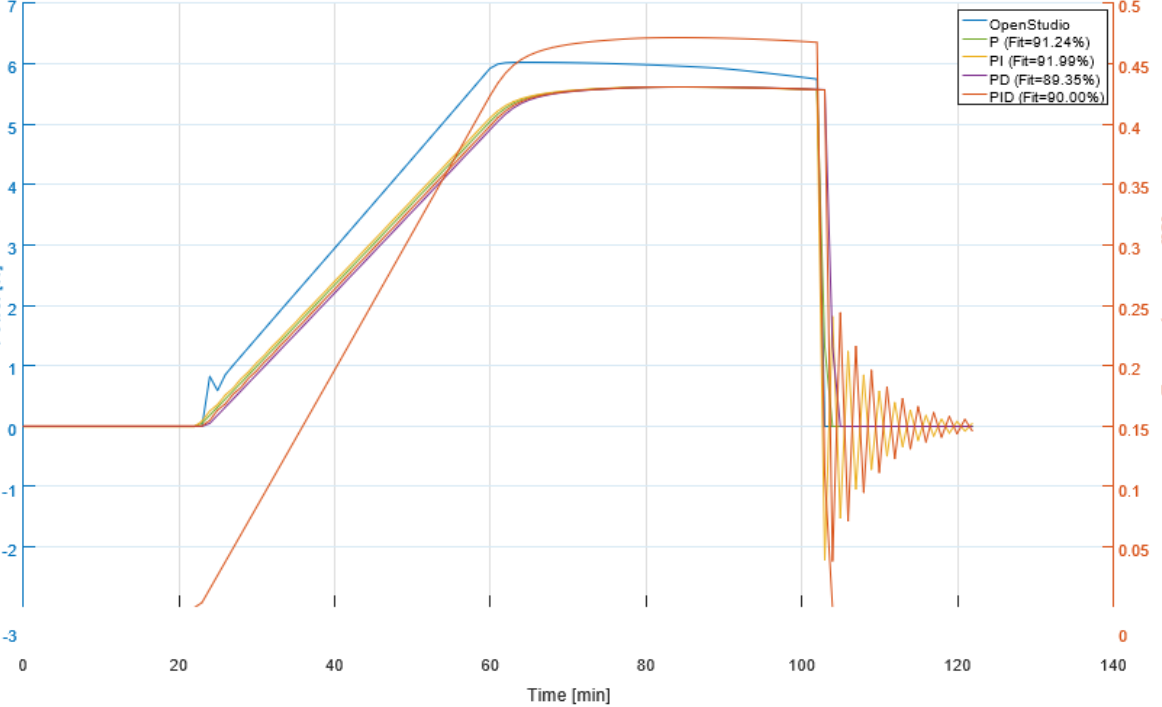
Figure 22. Temperature error (e(t)) and its required heating load for the OpenStudio simulation and 3 system identified transfer functions for the controller.